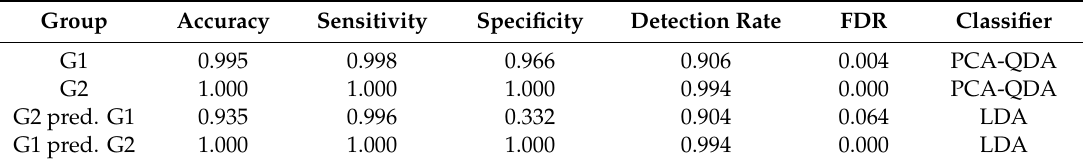
Table 2. Classification performance of four di ff erent classifier models based on DMPs identified from the placenta tissue of children with autism by signal